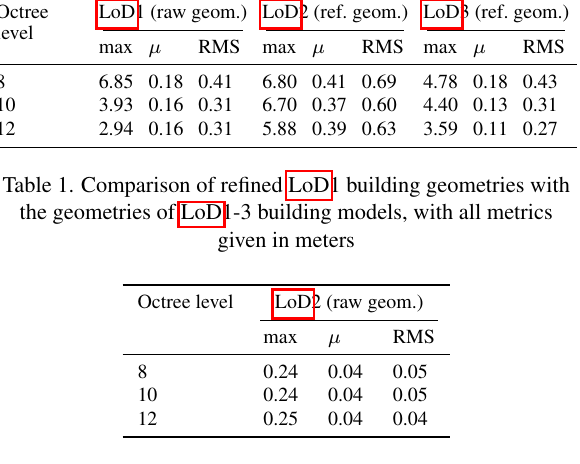
Table 2. Comparison of the refined road geometries with the raw geometry, with all metrics given in meters deviate by about 0.2m distance. The deviation measures for the road segments (see Table 2) show no significant gain when the octree level is increased. Nevertheless, the qualitative assessment indicates that more details can be extracted, as presented in Fig- ure 8.